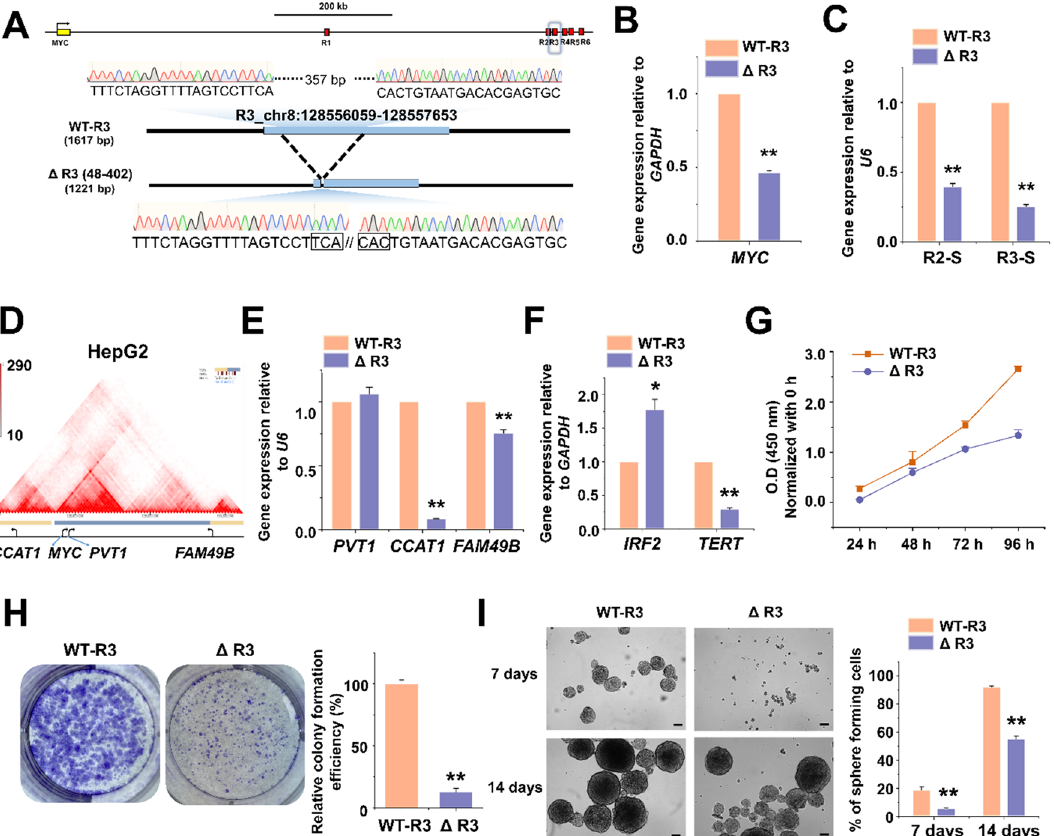
Figure 4. Generation of MYC enhancer region-deleted Huh7 cells via the CRISPR/Cas9 system. ( A ) Schematic illustration of the MYC enhancer locus structure and the wild-type (WT) and mutant (ΔR3) allele sequences around the R3 target region of Huh7 cells. ( B ) qRT-PCR results showing the levels of MYC mRNA, (C) R2 and R3-associated eRNAs in WT and R3-edited Huh7 cells. ( D ) TAD of MYC from Hi-C matrix of heatmap on chr8:126,840,000–130,080,000 in HepG2 cells (http:// 3dgen ome. fsm. north weste rn. edu/ view. php). ( E ) qRT-PCR results showing the levels of MYC -related lncRNA and ( F ) MYC -related gene mRNAs in WT and R3-edited Huh7 cells. The values are the mean ± SD from triplicate well measurements. * p < 0.05 and ** p < 0.01. ( G ) Cell proliferation was determined using a WST-1 assay and represented by the relative absorbance at 450 nm. WT and edited Huh7 cells were cultured in a growth medium for 96 h. The obtained absorbance was normalized to each 0 h absorbance. The data represent three biologically independent experiments. ** p < 0.01. ( H ) Colony formation ability of WT and R3-edited Huh7 cells. Cells were grown for 10 days and stained with Crystal Violet. The relative colony formation efficiency was measured as a percentage of the area covered by the colonies. The data represent three biologically independent experiments. ** p < 0.01. ( I ) WT and R3-edited Huh7 cells were cultured in cancer stem cell (CSC) growth media for a spheroid formation assay under ultralow adherence conditions. Cells grown for 7 days and 14 days in spheroid-forming conditions are shown in bright-field images taken with a 4X objective. The number of large spheres (over 100 µm) was counted; scale bar = 100 µm. The data represent three biologically independent experiments. ** p <